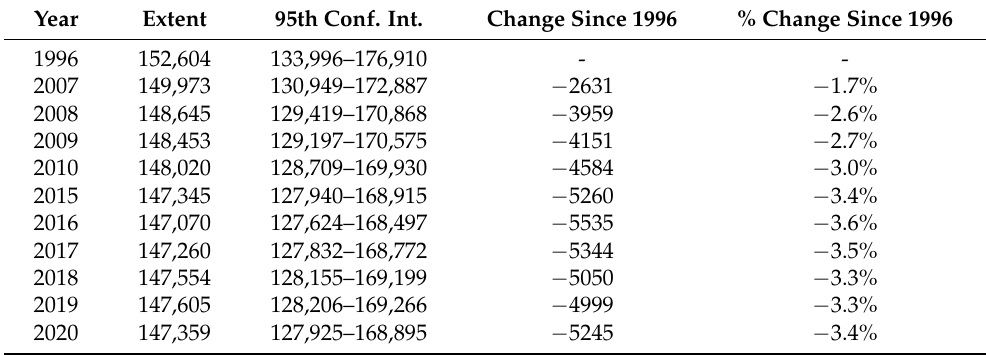
Table 5. Global mangrove extent estimates 1996–2020 and change since 1996 in km 2 . Note: reported mangrove extent estimates account for known map commission and omission